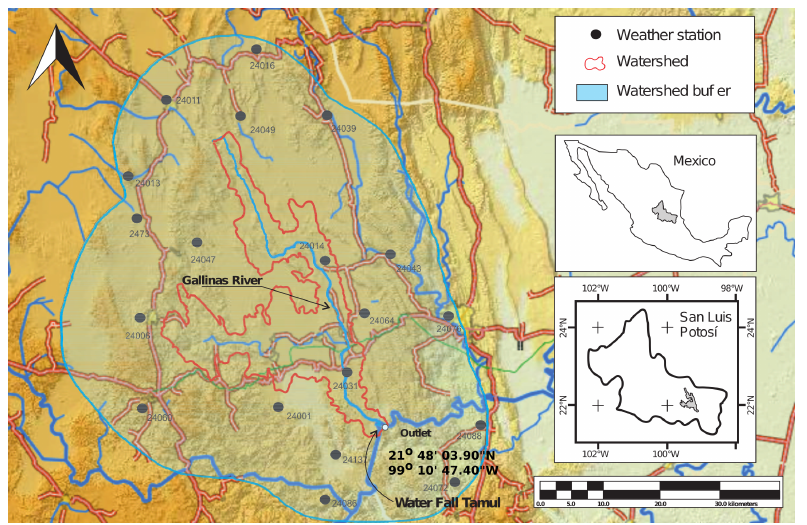
Figure 1. Location of the study zone. Delimitation of the watershed (red) of the Gallinas sub-basin from the outlet at the Tamul waterfall. The main channel or main collector is marked in